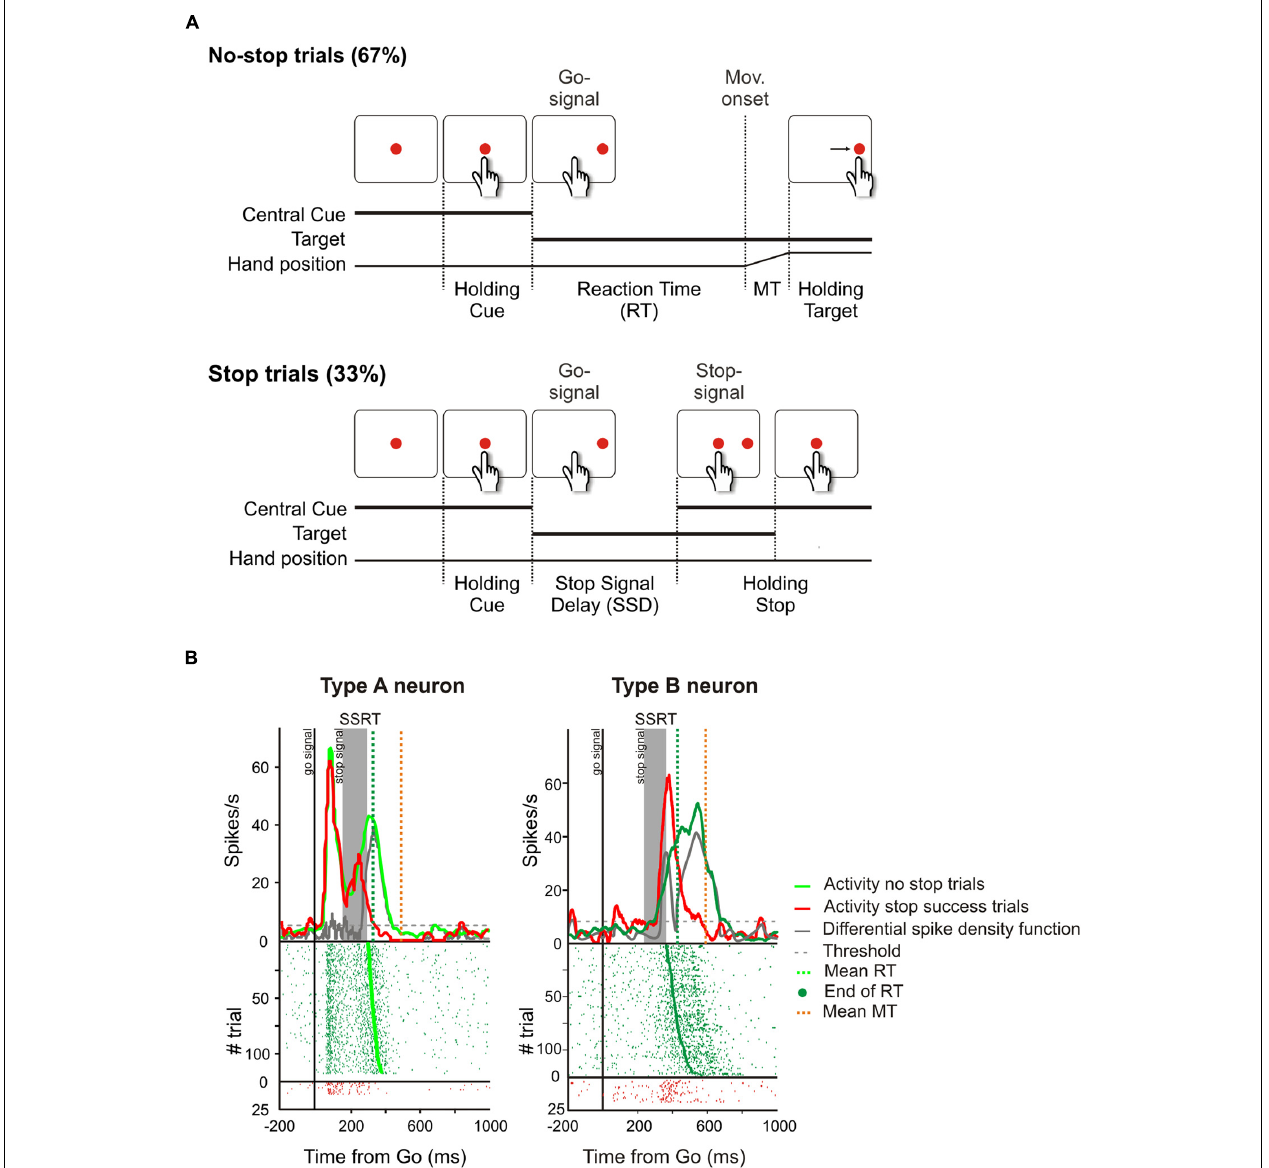
(red tick-marks). Neural activity was always aligned to the go-signal onset (first vertical line).The gray band represents the estimated duration of the stop-signal reaction time (SSRT) in that session.The gray line represents the differential spike density function, while the dashed gray line represents the threshold value for significant divergence.The green and the orange vertical dotted lines in the top panels indicate the average RT and the average end of MT, respectively.The green dots in the rasters represent the end of the RTs. On the right, the activity of a representative “type A” countermanding neuron is shown. In this cell, neural activity during stop-success trials (red line) initially resembles that of no-stop trials (green line) but, with a delay after the stop-signal presentation, it suddenly starts to decrease and the differential spike density function crosses the threshold 34.4 ms before the end of the SSRT. On the left, the activity of a representative “type B” countermanding neuron is shown. In this instance, the activity in stop-success trials increases after stop-signal presentation with respect to that recorded during no-stop trials 39.9 ms before the end of the SSRT. Therefore both these two types of neurons exhibit a modulation of activity sufficient to control the suppression of an ongoing arm